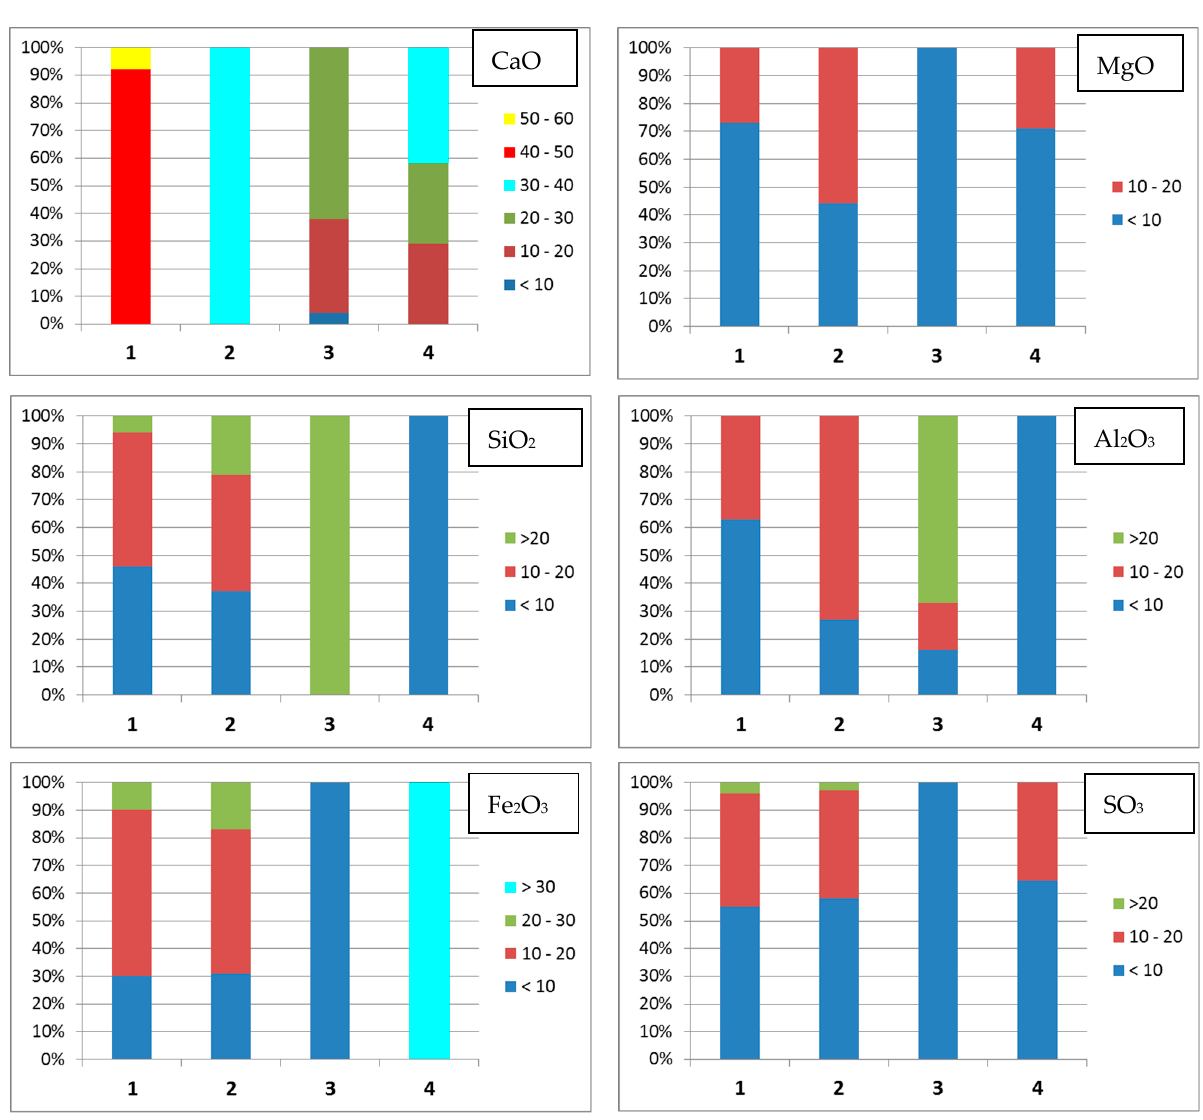
Figure 4. Percentage of individual microspheres PM 1-2 in different Groups with the content of a certain oxide lying in the specified range of values (wt %).